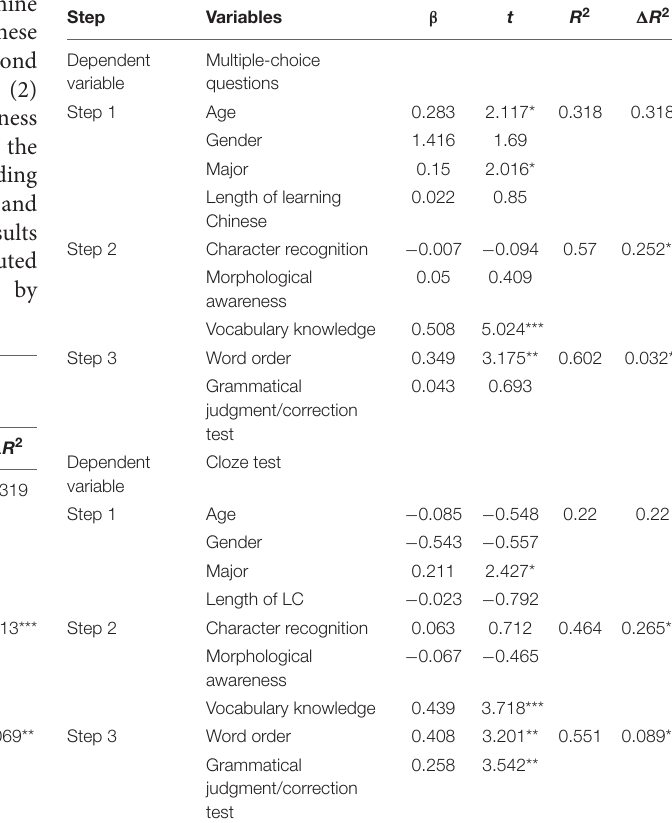
TABLE 4 | Multiple regression analysis predicting two types of reading comprehension